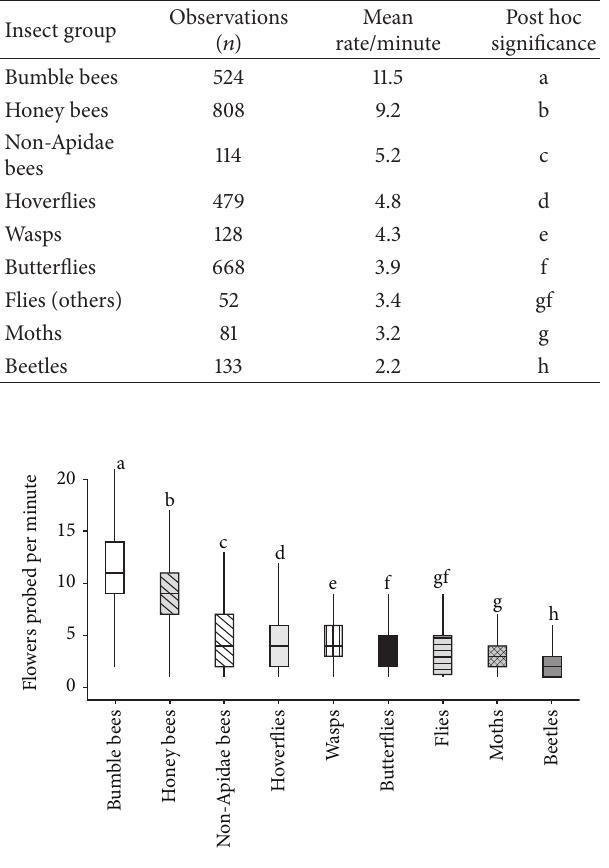
Figure 3: Insect pollinator groups significantly differ in the rate at which they probe flowers. Bumble bees (11.5 flowers/minute) and honey bees (9.2 flowers/minute) have the quickest rate of flower visitation, whereas beetles are the slowest (2.2 flowers/minute). Letters display post hoc results, where groups that share letters do not significantly differ. All pairwise comparisons significantly differed from each other, with the exception of flies and butterflies as well as flies and moths. Groups are ranked according to their flower probing rate. Box lines report medians and lower and upper quartiles,andwhiskersextendeithertomaximumorminimumdata points or to 1.5 times the interquartile